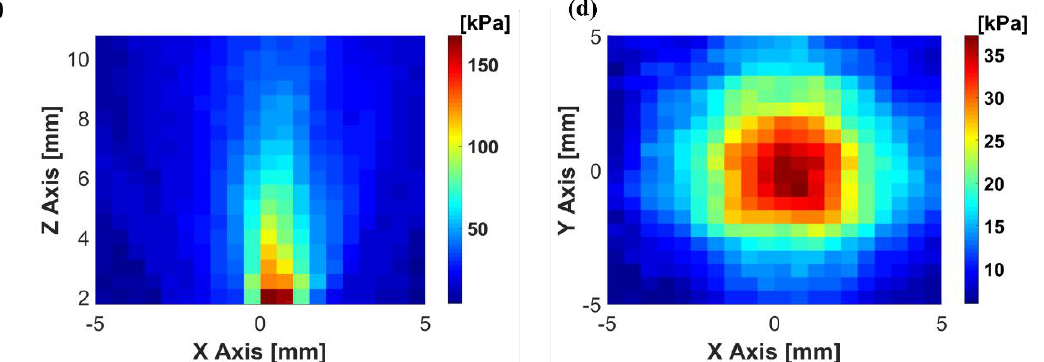
Figure 2. ( a ) Cross-section of the CMUT cell; ( b ) photograph of 2D CMUT array; ( c ) pressure field of the vertical direction; ( d ) pressure field of the horizontal direction at z = 11 mm.